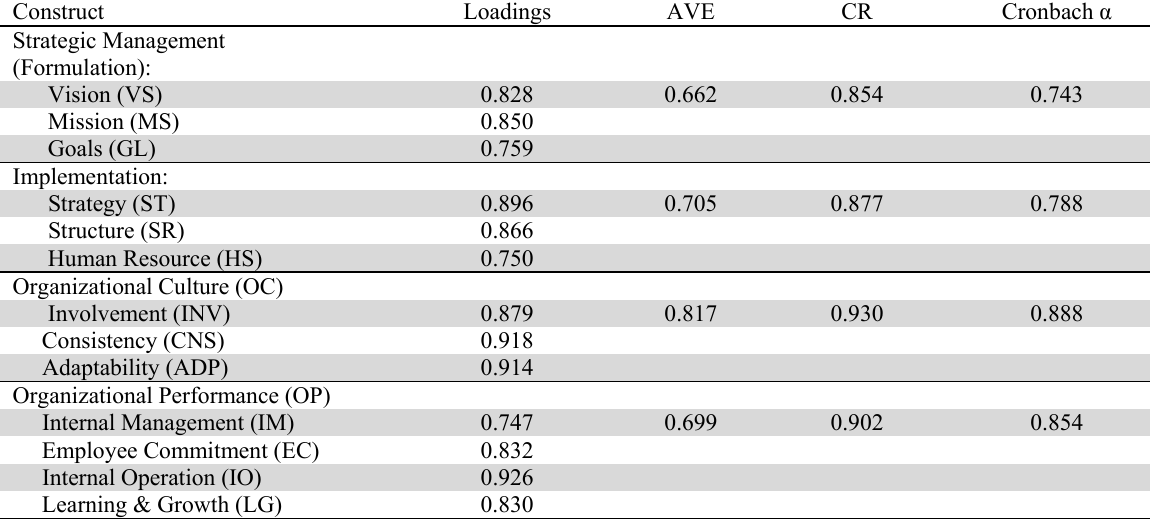
Overall Measurement Model